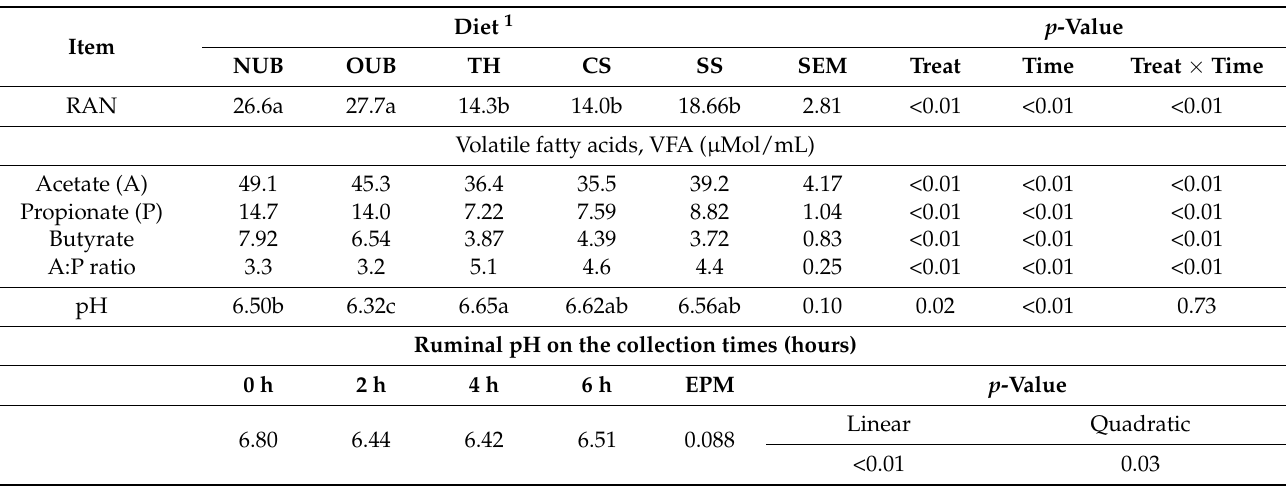
Table 6. Effects of treatment and collection time on concentration of rumen ammonia nitrogen (RAN, mg/dL), volatile fatty acids, and ruminal pH in